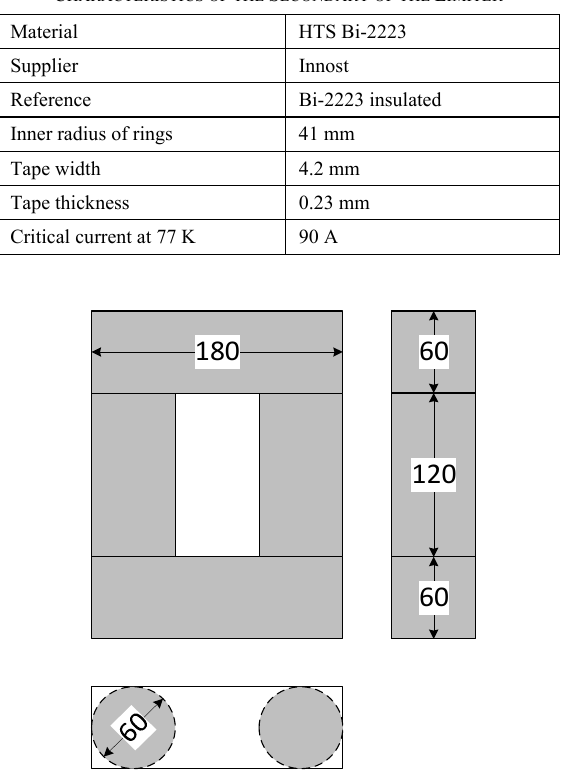
Fig. 1. Dimensions (in millimeters) of the magnetic core used to perform the limiter.